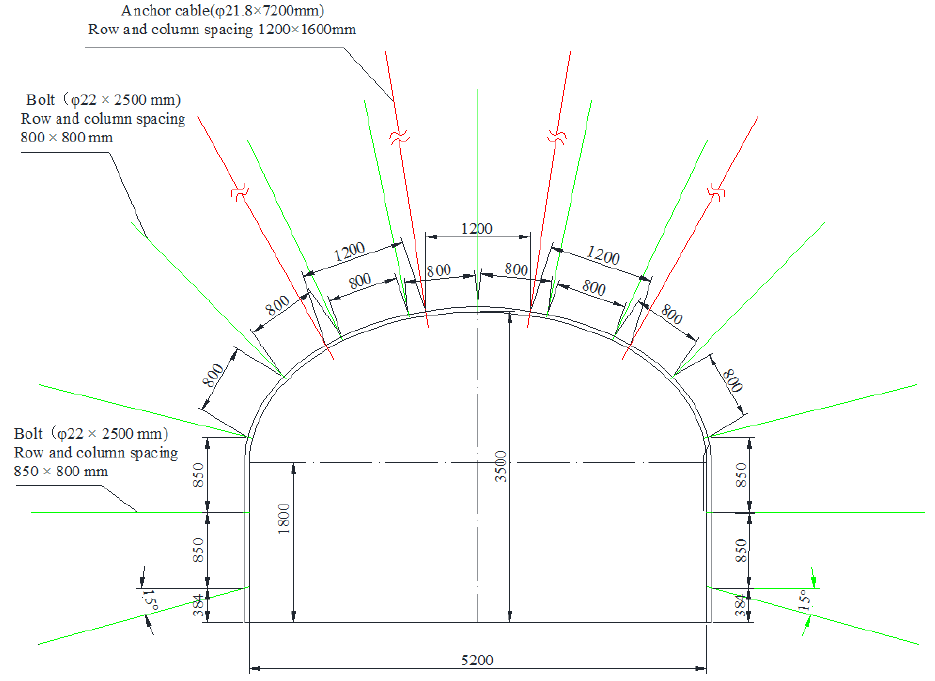
Figure 10. Roadway support design.